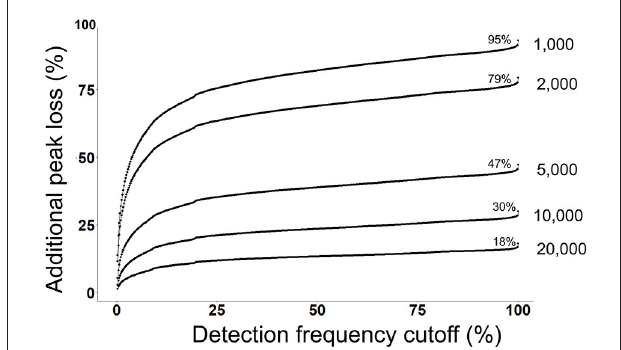
FIGURE 3 | Detection frequency cutoffs and peak rejection in LC/MS data processing. For each peak height cutoff (1,000, 2,000, 5,000, 10,000, and 20,000) (TH2), a count of total retained peaks which were found in at least one sample was obtained as shown by the % values on each curve. Y-axis shows the loss of peaks as a function of detection frequency cutoffs. For example, at a detection frequency cutoff of 50% and peak height cutoff of 10,000, additional 20% peaks will be lost, retaining only 10% peaks.